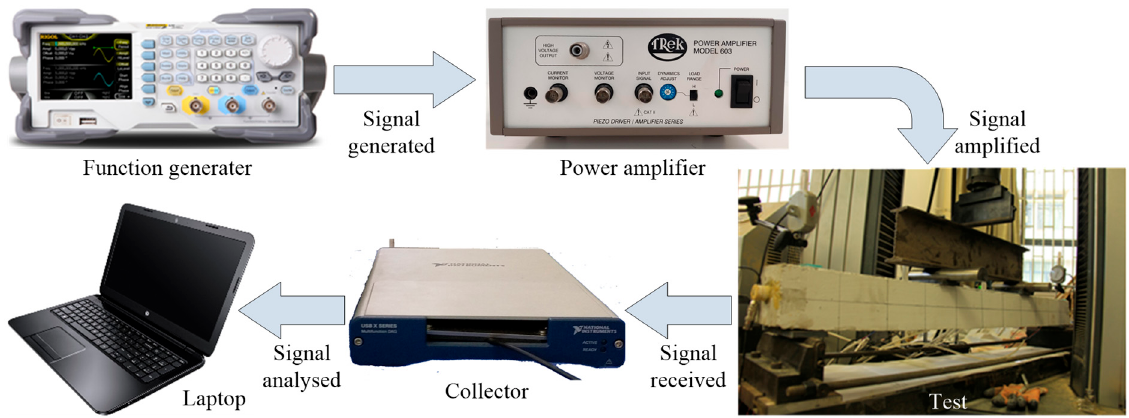
Figure 8. Schematic of test system for damage monitoring.